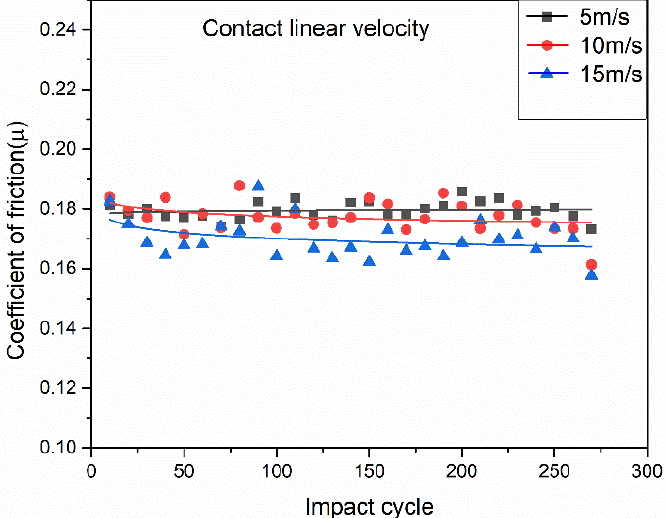
Figure 7. Changes in the coefficient of friction depending on different contact linear velocity of pin specimens.